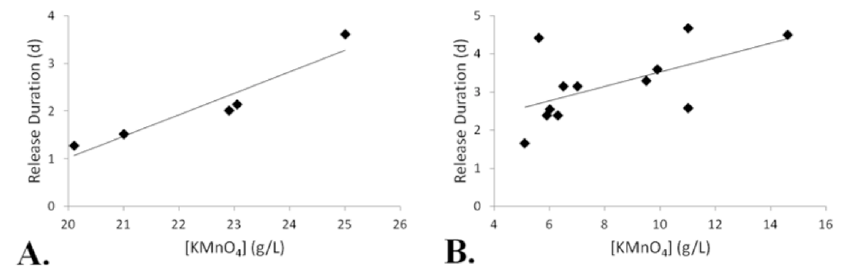
Figure 4. Release duration of ( A ) B-40 SRPG solutions and ( B ) B-50 SRPG solutions as a function of KMnO 4 concentration.